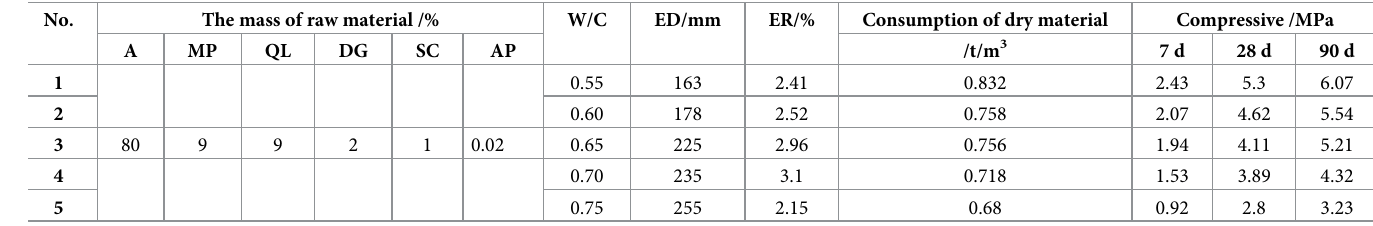
Table 6. Influence of the water-to-material ratio on the material performance. No. The mass of raw material /%